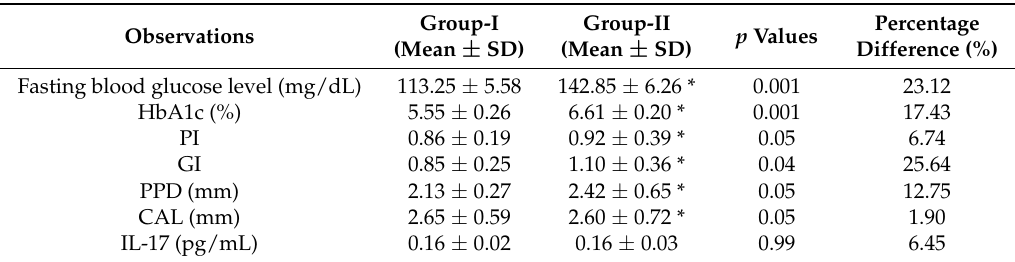
Table 4. Comparison of periodontal and biochemical parameters between the groups one month after NSPT.